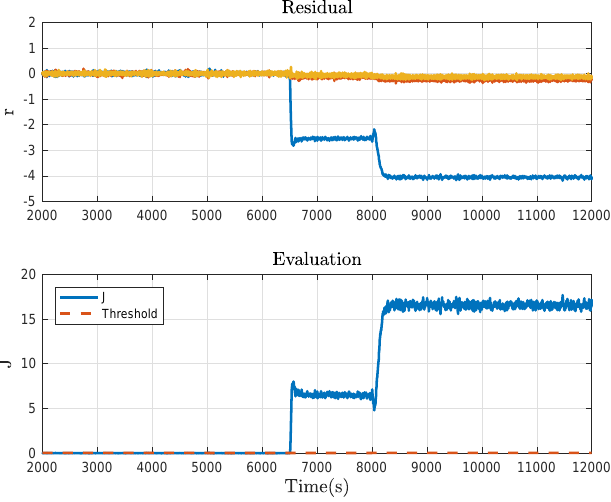
Figure 9. Fault detection result under the offset fault.